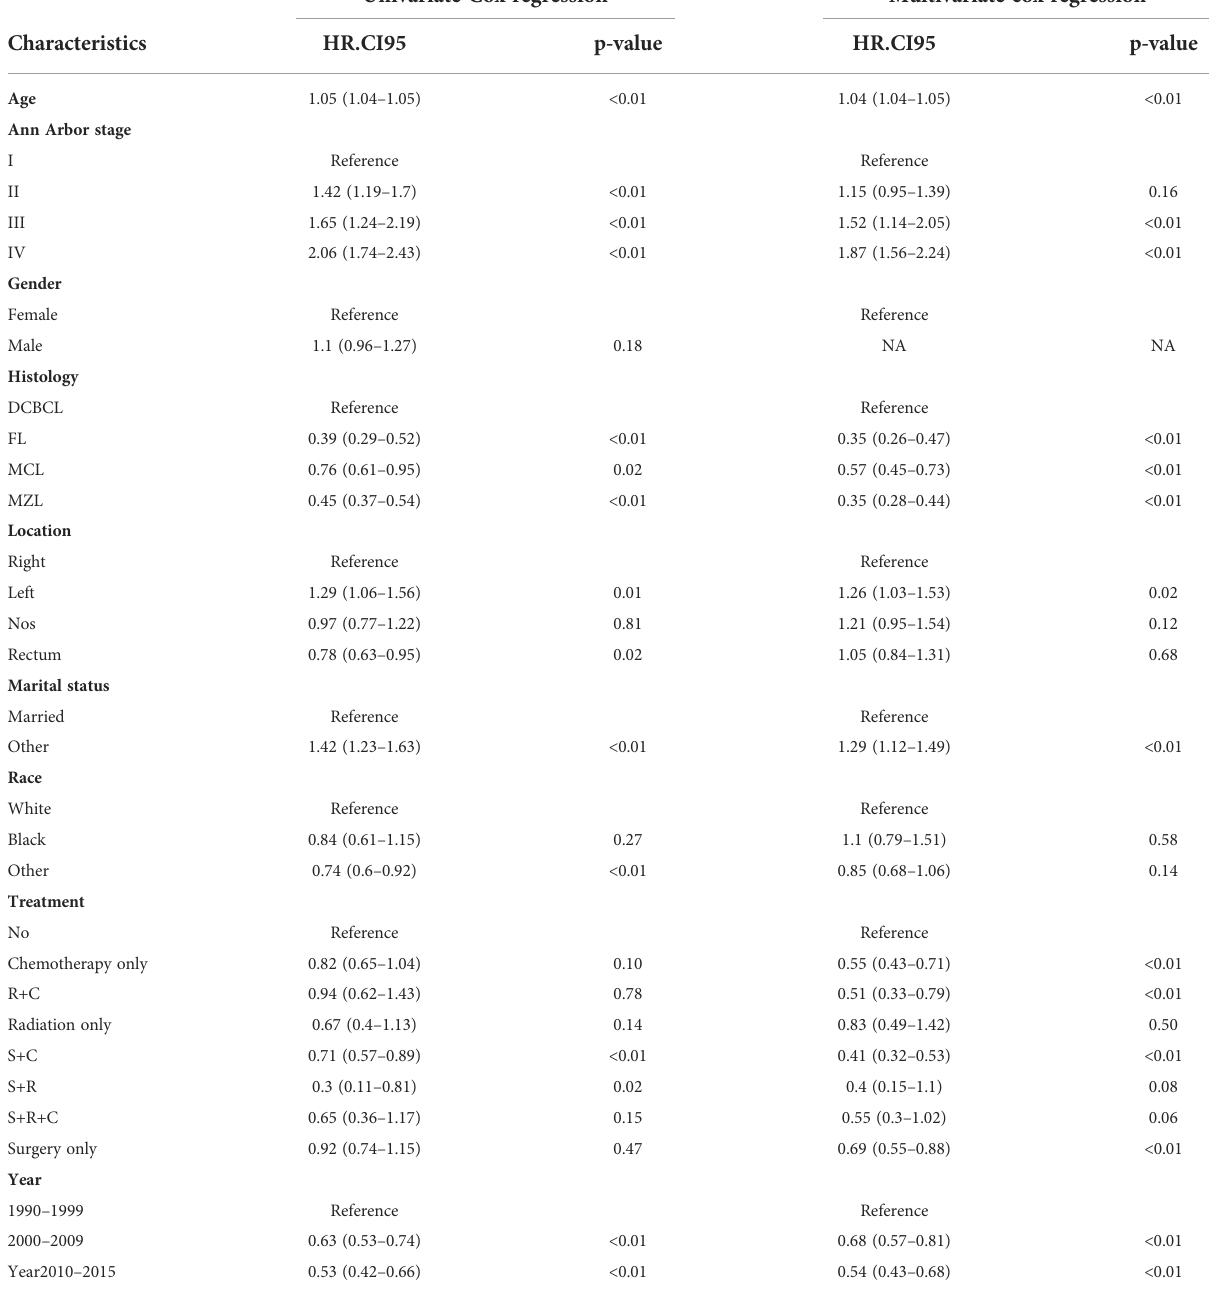
TABLE 2 Univariate and multivariate Cox regression analysis of